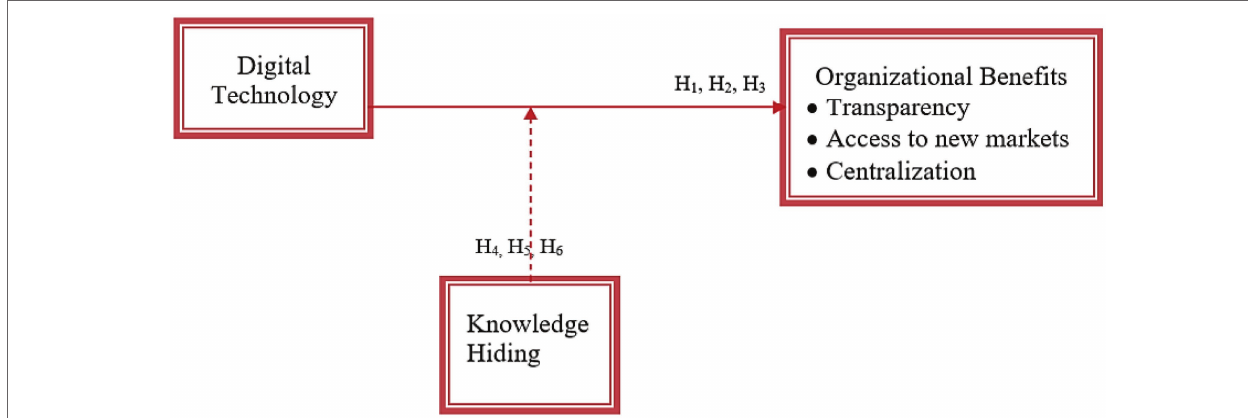
FIGURE 1 | Conceptual framework. Central, Centralization; DT, Digital technology; NM, Access to new markets.